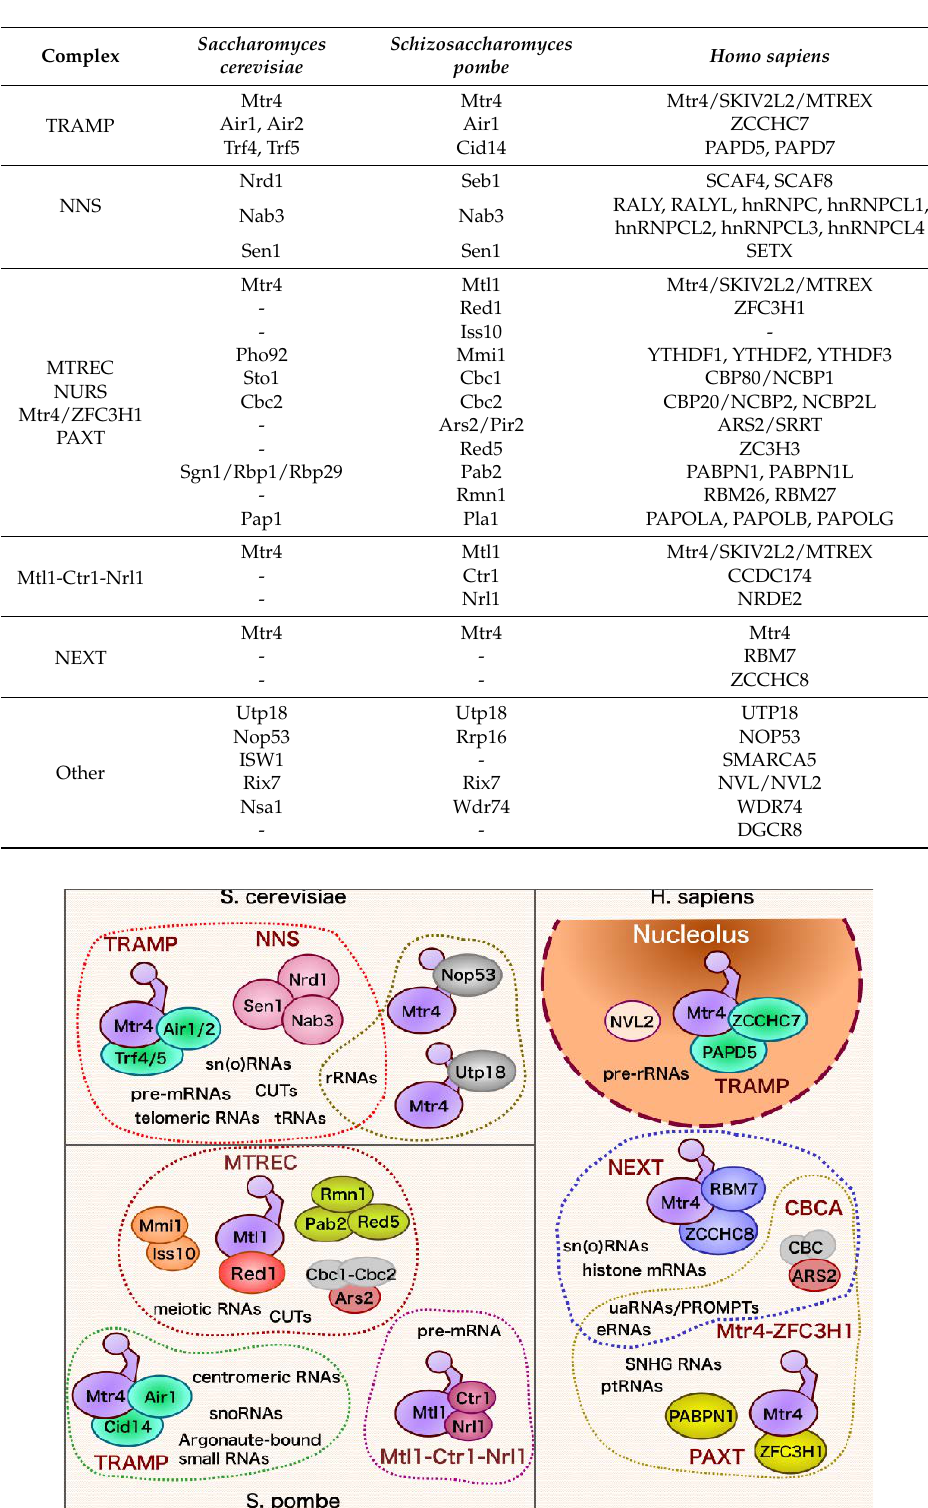
Table 1. Conservation of exosome co-factors in yeasts and humans.